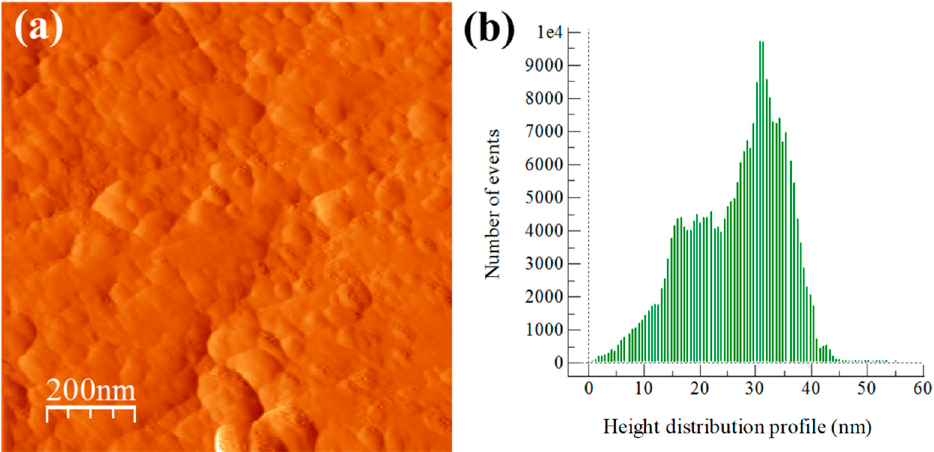
Figure 6. Al / C composite after the extrusion process: ( a ) AFM topography image and ( b ) height Figure 6. Al/C composite after the extrusion process: ( a ) AFM topography image and ( b ) height Figure 6. Al/C composite after the extrusion process: ( a ) AFM topography image and ( b ) height Figure 6. Al/C composite after the extrusion process: ( a ) AFM topography image and ( b ) height distribution profile of surface distribution profile of surface roughness. distribution profile of surface roughness. distribution profile of surface roughness.